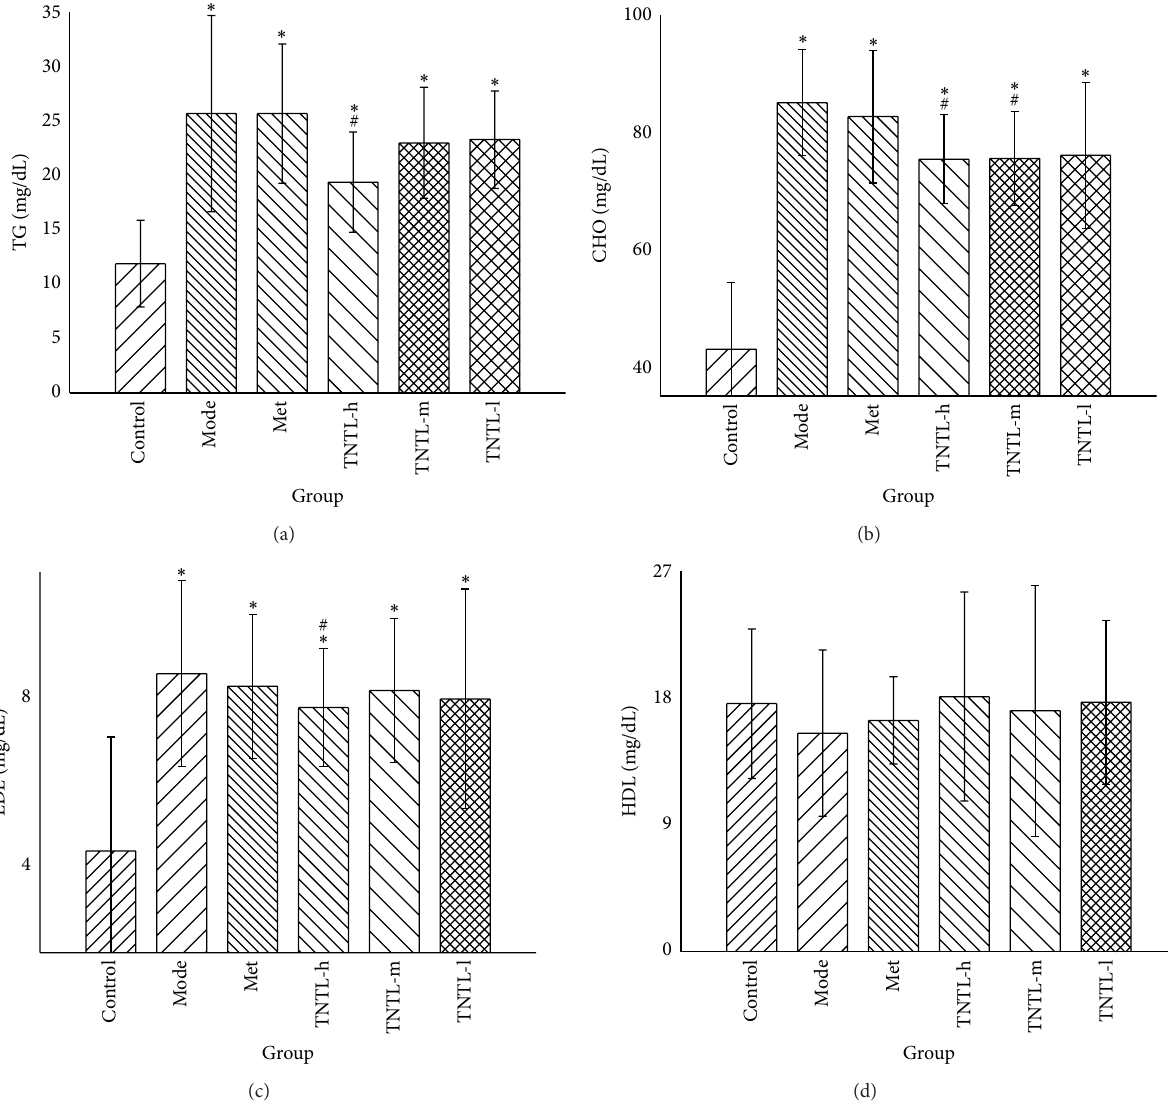
Figure 6: Lipid profile in db/db mice. The TNTL (TNTL-h, m, l means the dose of 3.6 g, 1.8 and 0.9 g/kg b.w., resp.) administration leads to reductions in plasma levels of triglycerides (a), total cholesterol (b), and low-density lipoprotein (c), respectively, compared to the model group. Mice treated with TNTL (3.6g/kg) showed significant reductions in total cholesterol (TC), CHO, and low-density lipoproteins (LDL) (25%, 11%, and 10%, resp.), compared to controls. Control: C57BL, DM: db/db mice with untreated, Met: db/db mice treated with metformin, and TNTL-h, m, l: db/db mice treated with 3.6 g, 1.8 and 0.9 g/kg b.w., respectively. # 𝑃 < 0.05 compared with DM group. ∗ 𝑃 < 0.05 compared with control